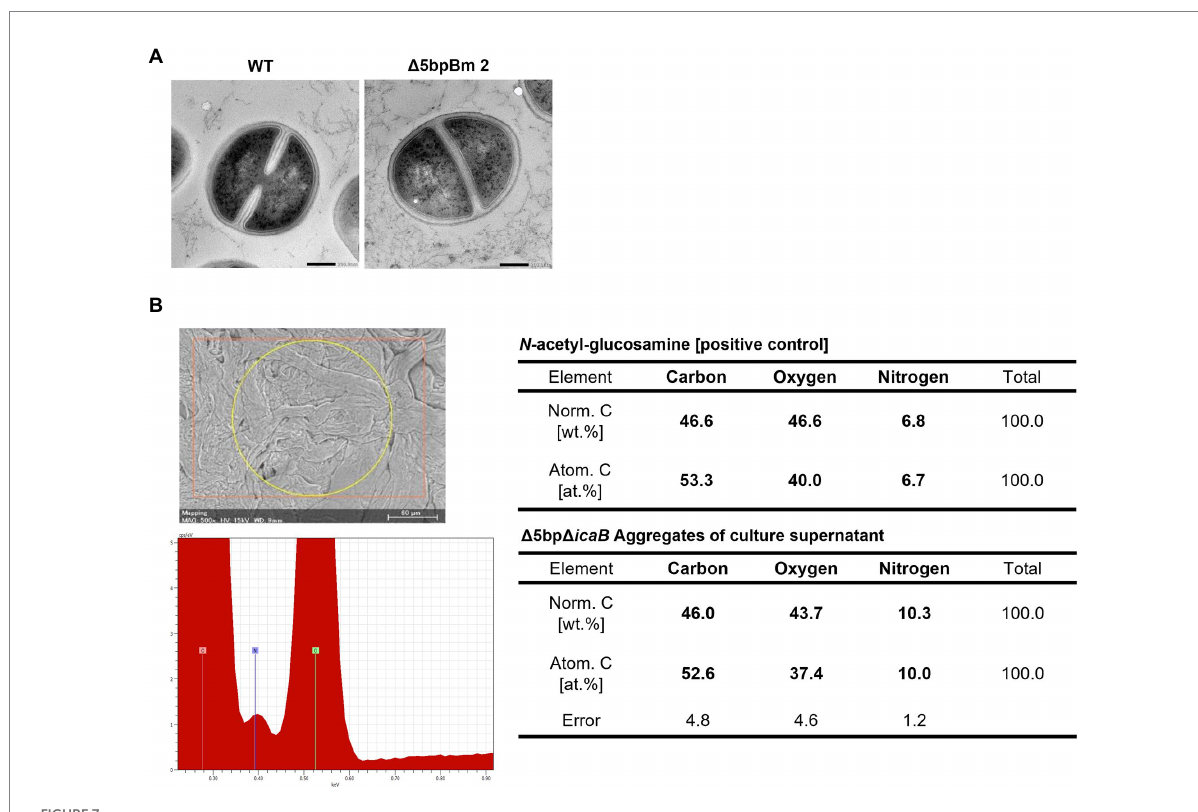
FIGURE 7 Searching for autoaggregation factors using electron microscopy and elemental analysis. Morphological and elemental analysis of autoaggregation factor(s) using electron microscopy. (A) Ultrastructural observation of Staphylococcus aureus FK300 Δ 5bpBm 2 using transmission electron microscope. S. aureus FK300 (left) and S. aureus FK300 Δ 5bpBm 2 (right). (B) Elemental analysis of the autoaggregate from FK300 Δ 5bp Δ icaB supernatant. Autoaggregates obtained by vortexing the culture supernatant of FK300 Δ 5bp Δ icaB were dried and examined via a scanning electron microscope (Mini Scope TM-3030) for element analysis. As a control, the value of N -acetylglucosamine is shown. WT; wild type strain FK300. The top left figure is SEM image of a sample irradiated with characteristic X-rays. The bottom left figure is EDS spectrum. The right is a table of elemental ratios of flocculence samples and N